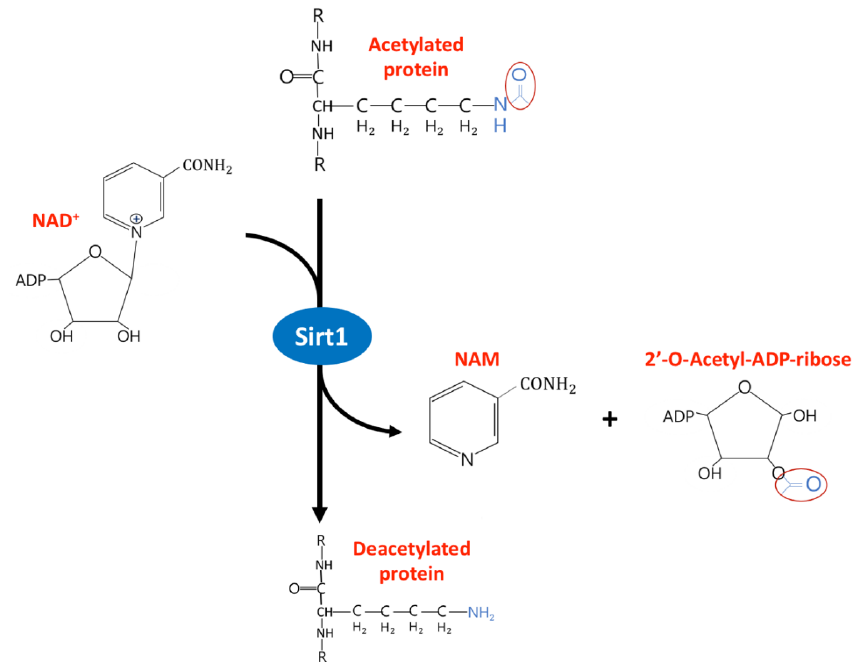
Figure 1. Enzyme activity of Sirtuins-1. NAD+ receive acetyl-lysine residues from the target protein during the deacetylation process and generate nicotinamide (NAM) and 2’ -O-Acetyl-ADP-ribose. NAD, Nicotinamide adenine dinucleotide and NAM, nicotinamide.